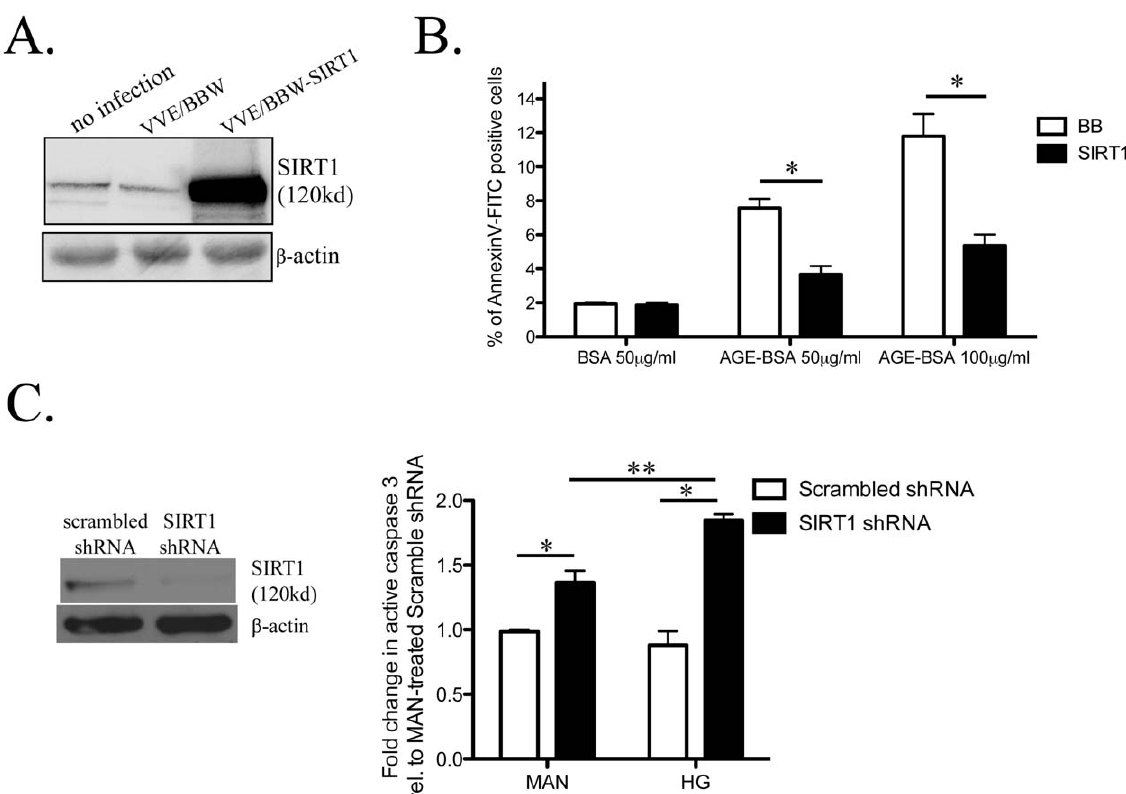
Figure 5. Sirt1 overexpression and knockdown on podocyte apoptosis. The expression of Sirt1 in murine podocyte without infection (no infection), infected with the empty lentivirus VVE/BBW (BB), or infected with the VVE/BBW-Sirt1 lentivirus with stable overexpression of Sirt1 (Sirt1) was confirmed by Western blotting (A). Apoptosis of BB ( % ) and SIRT ( & ) podocytes treated with BSA (50 m g/ml) or AGE-BSA (50 and 100 m g/ml) for 16 h were quantified by flow cytometry after annexin-V-FITC labeling (B). *p , 0.05, n=3. Murine podocytes tranduced with either a scrambled shRNA or Sirt1-targeting shRNA were treated with either 30 mM of mannitol (MAN) or glucose (HG). Knockdown of Sirt1 expression was confirmed by Western blotting (C). Fold change in active caspase compared to scrambled shRNA podocytes treated with MAN is shown. *p , 0.05,